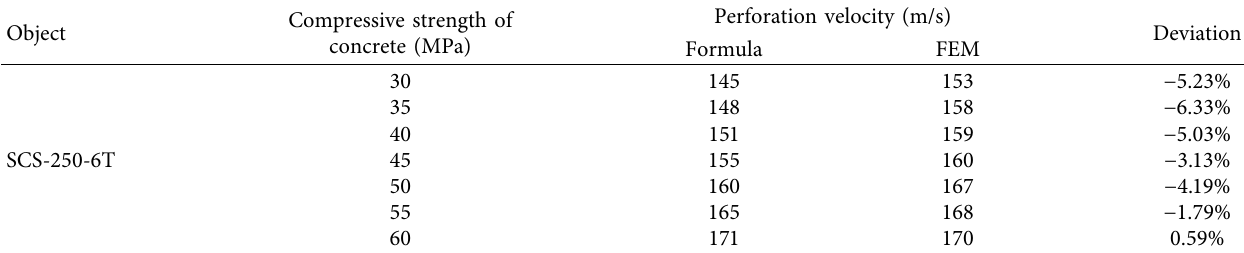
Table 10: Perforation velocity comparison of SCS wall with different conditions of concrete for the flat projectile. Object